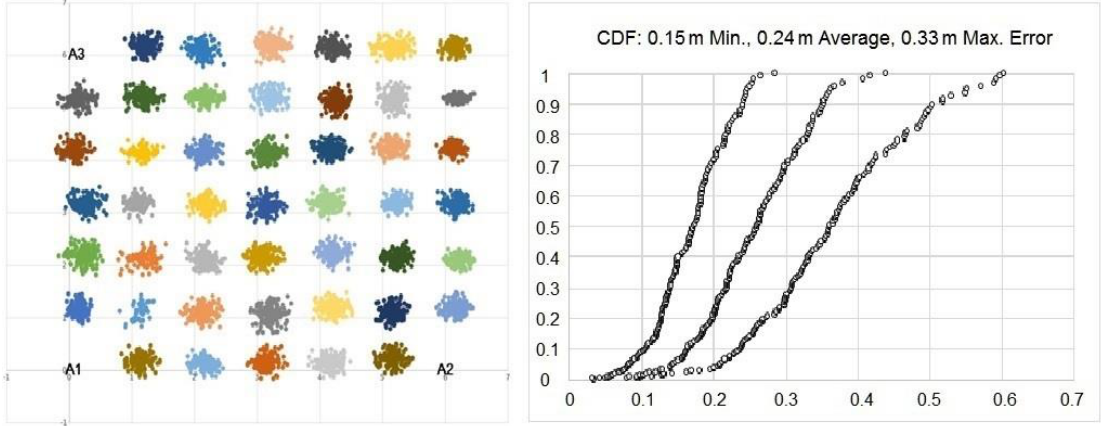
Figure 1. Test results of ultra-wide band sensors in a 36 m 2 (6 m × 6 m) test area for 6900 measurements and the cumulative distribution function (CDF) of the test points of minimum, maximum and average localization errors (in meters) determined by the UWB positioning system.